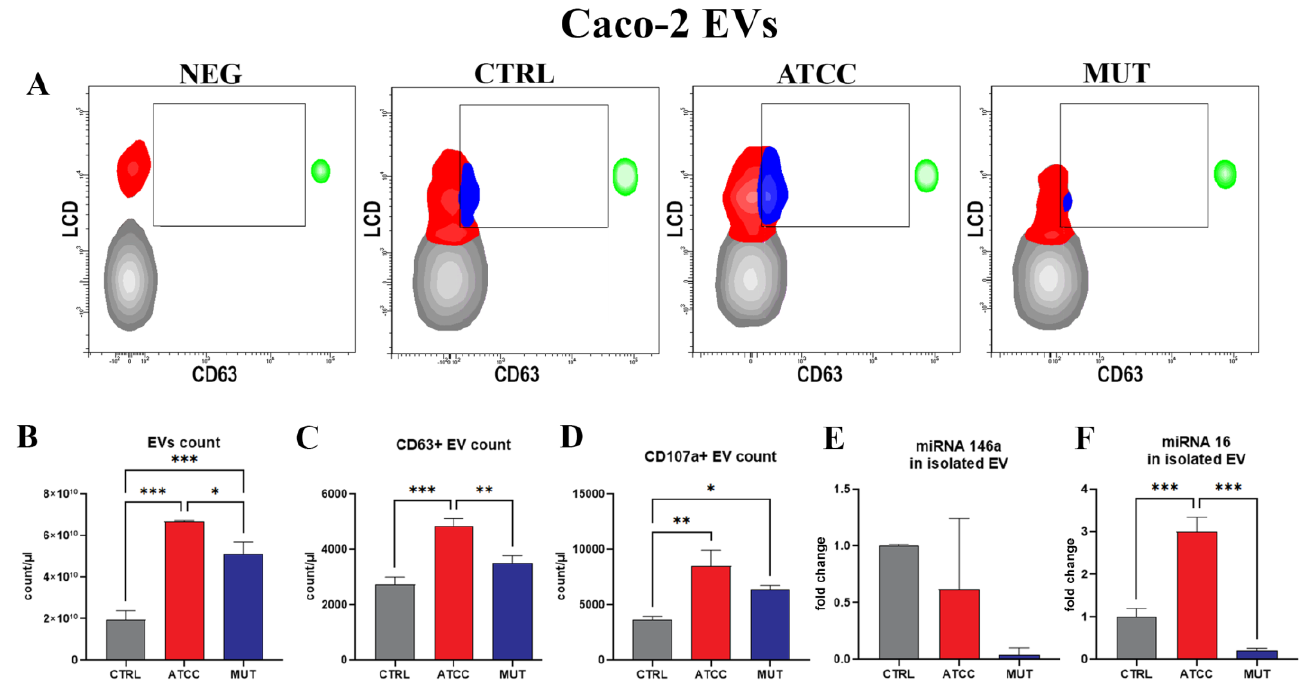
Figure 3. ( A ) Density plot of EVs from the Caco-2 cells of NEG, CTRL, ATCC, and MUT at 72 hours. Red area indicates EV positive for LCD, blue area indicates EV positive for CD63. Green area identifies cytometer counting beads. ( B ) Histogram of EV count at 72 h. ( C ) Histogram of CD63 positive EV at 72 h. ( D ) Histogram of CD107a+ EV at 72 hours. ( E ) Histogram of EV-miRNA-146a content. ( F ) Histogram of EV-miRNA-16 content. One-way ANOVA with Bonferroni’s multiple comparison test. The asterisk denotes a statistically significant difference (* = p < 0.05, ** = p < 0.01, *** = p < 0.001).